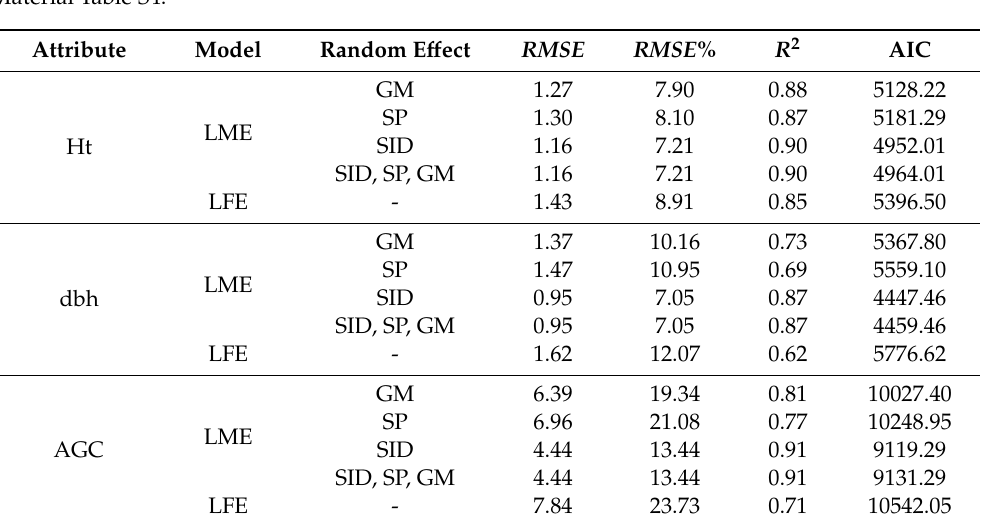
Table 2. Linear fixed- and mixed-e ff ect models (LFE and LME, respectively) performance for